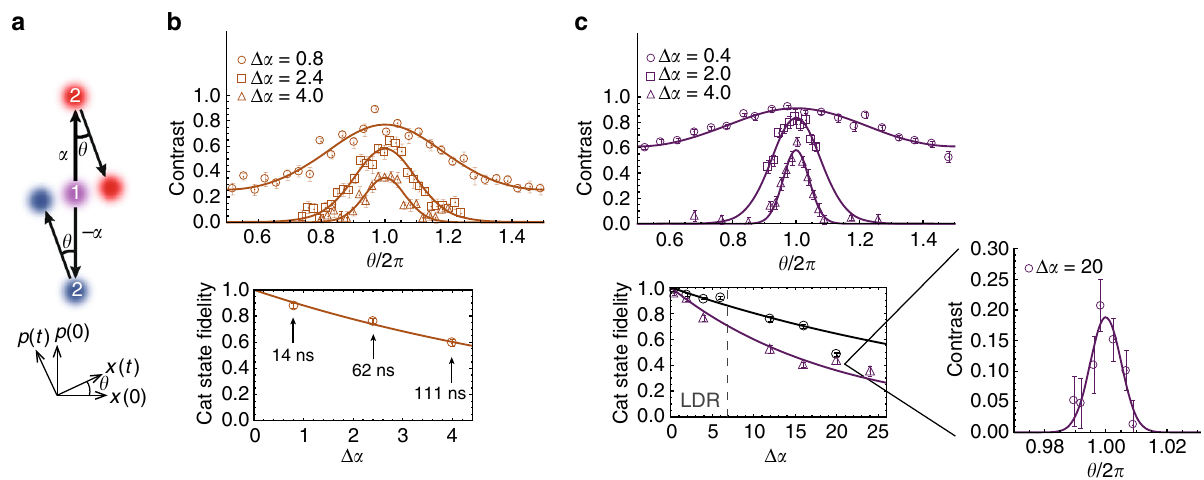
Fig. 3 Cat state creation and veri fi cation. a The state ψ 1 j i ¼ "j i þ #j i (labelled “ 1 ” ) is split using a set of SDKs to create the cat state ψ 2 j i ¼ "j i α j i þ #j i (cid:3) α j i ( “ 2 ” ) that has a separation of Δ α between its components. After evolution θ = ω T ( ω /2 π = 1.0 MHz), a second set of SDKs drives the state (cid:7) (cid:7) (cid:8) (cid:8) (cid:7) (cid:7) þ #j i α e (cid:3) i θ (cid:3) α to Ψ f j i ¼ "j i (cid:3) α e (cid:3) i θ þ α . b Switching each successive laser pulse as an SDK, the cat state ψ 2 j i with Δ α = 0.8 is generated in about 14 ns, Δ α = 2.4 in 62 ns and Δ α = 4.0 in 111 ns. The states are veri fi ed by observing contrast in the state Ψ j i ( upper plot ). We fi nd the fi delity of each cat state f ψ j i to be 0.88(2), 0.76(2) and 0.59(3), respectively ( lower plot ). c Using the evolution of the atom in the trap to swap SDKs, the generation is slower but 2 has higher fi delity because the laser beam paths are not alternating. The effective single SDK fi delities are 0.9912 and 0.98 for Doppler ( black circles ) and ground state ( purple triangles ) cooled atoms (lower plot; the dashed line in the lower plot signi fi es the limit of the Lamb-Dicke Regime (LDR)). These states are generated in times of (cid:5) ð Δ α (cid:3) 0 : 4 Þ ´ 1250 ns. Again, the states are veri fi ed by observing contrast in the state Ψ f j i ( upper plot ). The inset shows a cat state with separation Δ α = 20 and revival peak contrast of C 0 = 0.19(3). In b , c , error bars are statistical with con fi dence interval of ± one standard deviation. The solid lines are fi ts to the underlying theory (Eq. 4, with the peak contrast as the only fi t